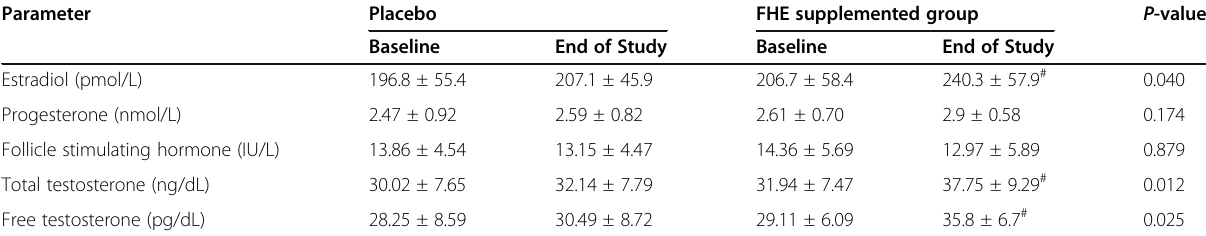
Table 3 Hormone levels of placebo and FHE groups Parameter Placebo FHE supplemented group P